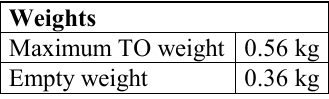
Table 3. Performance of Mini-UAV’s